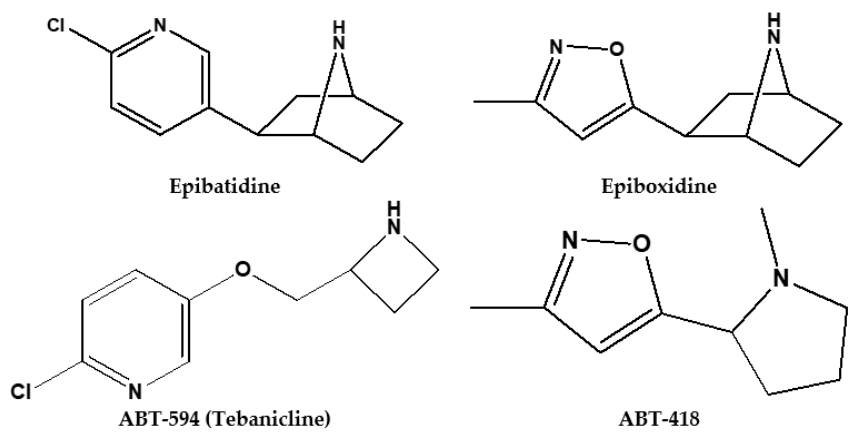
Figure 2. Epibatidine and its Figure2. Epibatidine and its analogues.